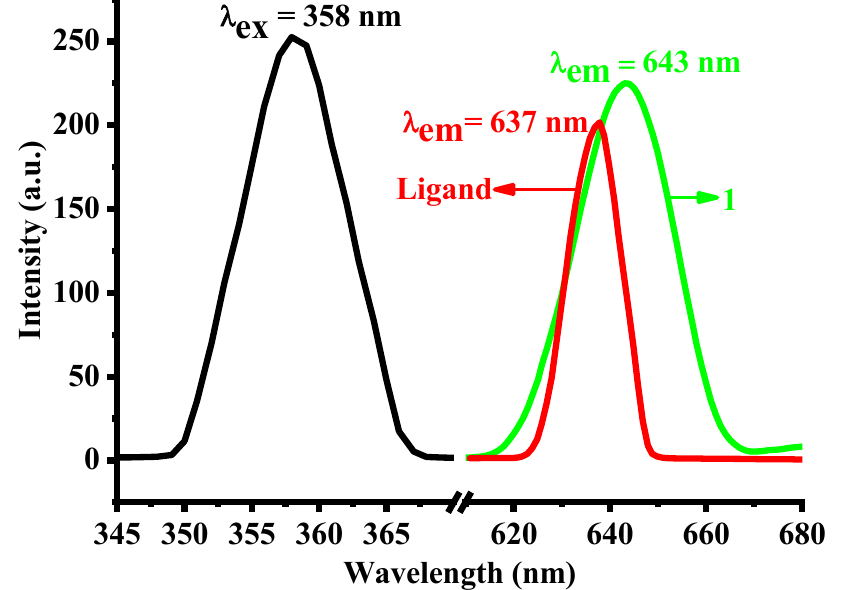
Figure 8. The luminescent properties of 1 and H 2 nba ligand in aqueous solution at room